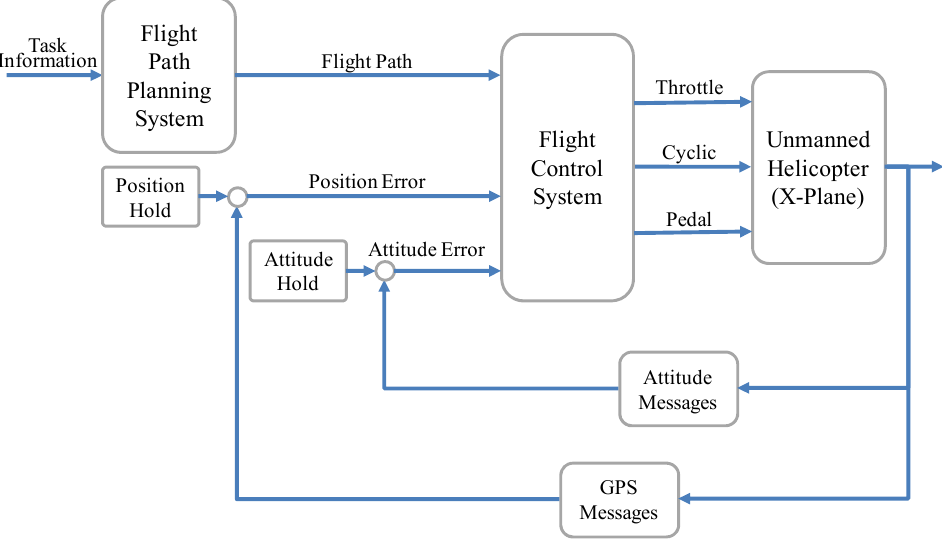
Figure 13. The architecture of the integrated